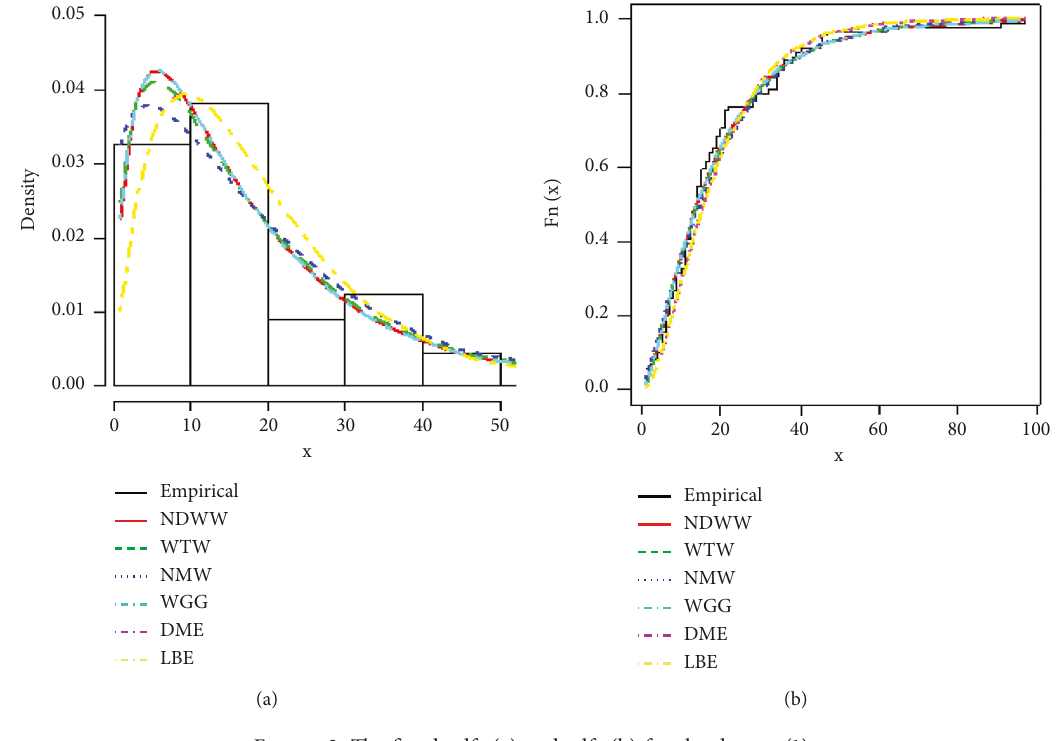
Figure 2: The fitted pdfs (a) and cdfs (b) for the dataset